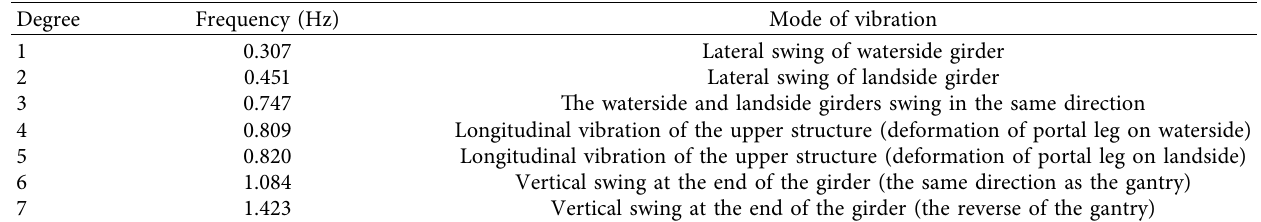
Table 4: The vibration characteristic of quay crane.